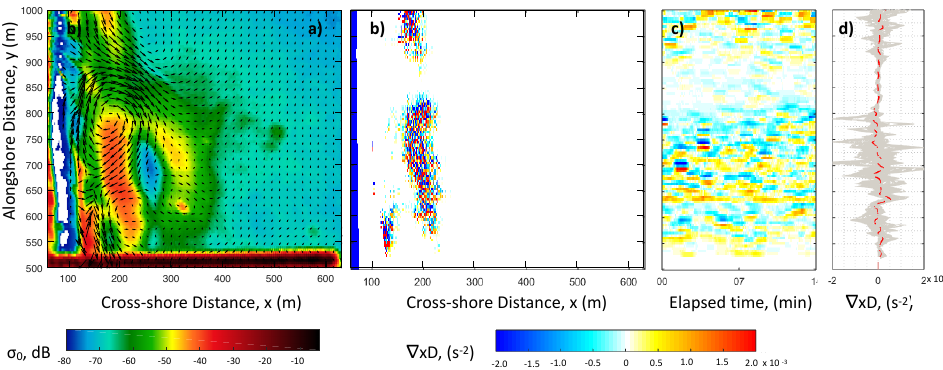
Figure 9. ( a ) Time averaged marine radar image from R2 showing the presence of a rip current, overlain velocity vectors obtained by Wilson et al. [43]; ( b ) Time average (10 T ) of the curl of the dissipation force; ( c ) time-space map of the curl of the dissipation force at transect x =200; ( d ) individual profiles (gray lines) and average (red) of data from panel ( c